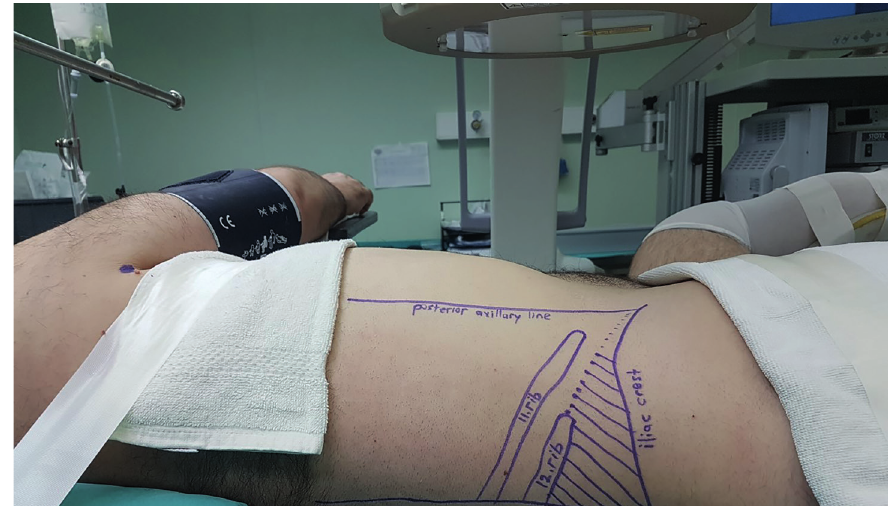
Figure 1 - Galdakao-Modified Valdivia position in supine m-PNL. The shaded area between lower rib, posterior axillary line and iliac crest shows the subcostal access